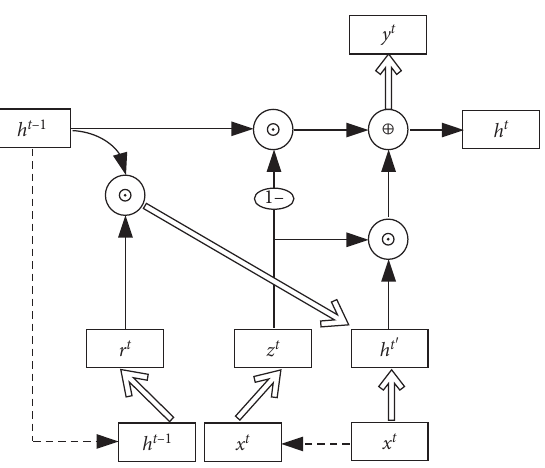
Figure 3: The internal structure of